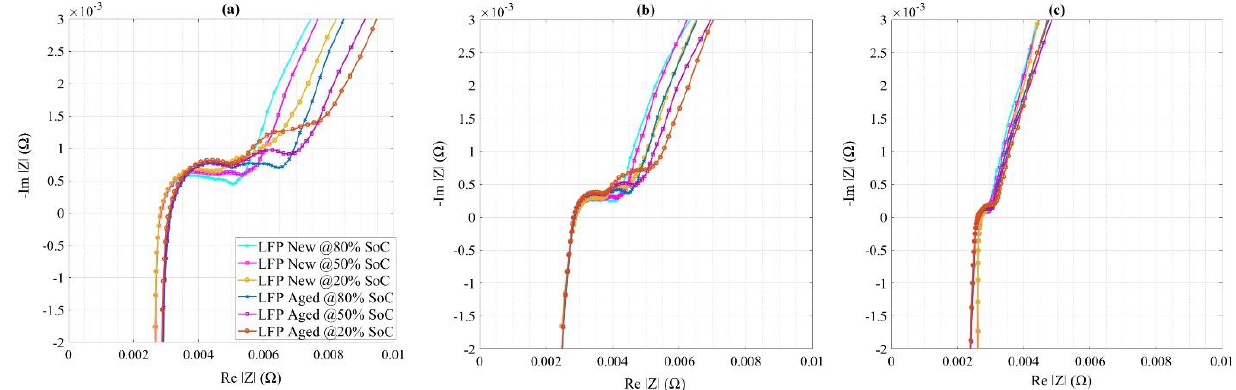
◦ C, ( b ) 25 ◦ C, and ( c ) 45 ◦